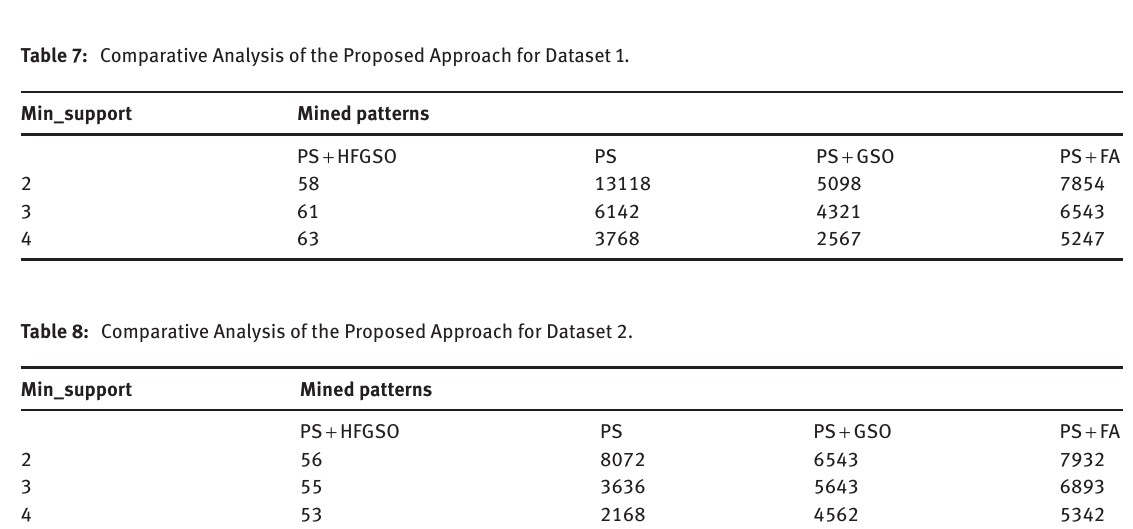
Figure 5: Performance Comparison Based on Computation Time. (A) Dataset 1. (B) Dataset